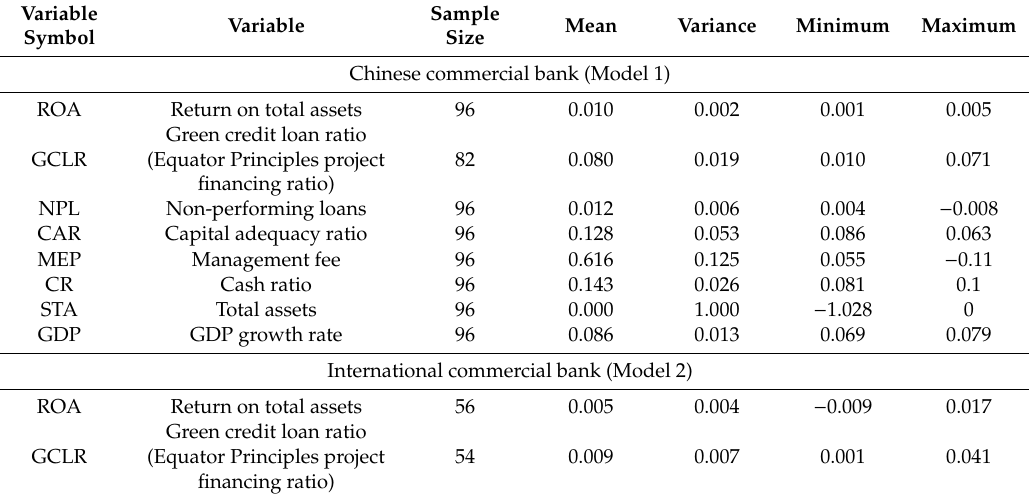
Table 1. Descriptive